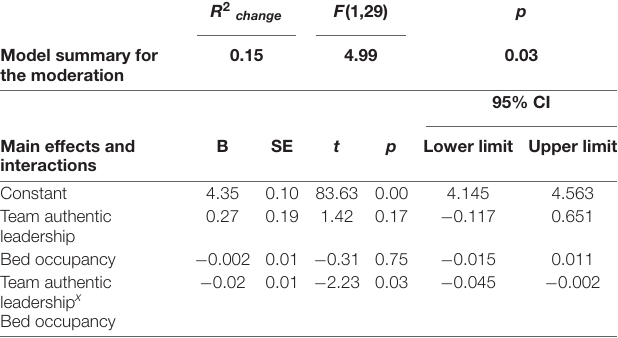
TABLE 2 | Moderation results for team performance as the outcome variable. R 2 change F (1,29) p Model summary for the